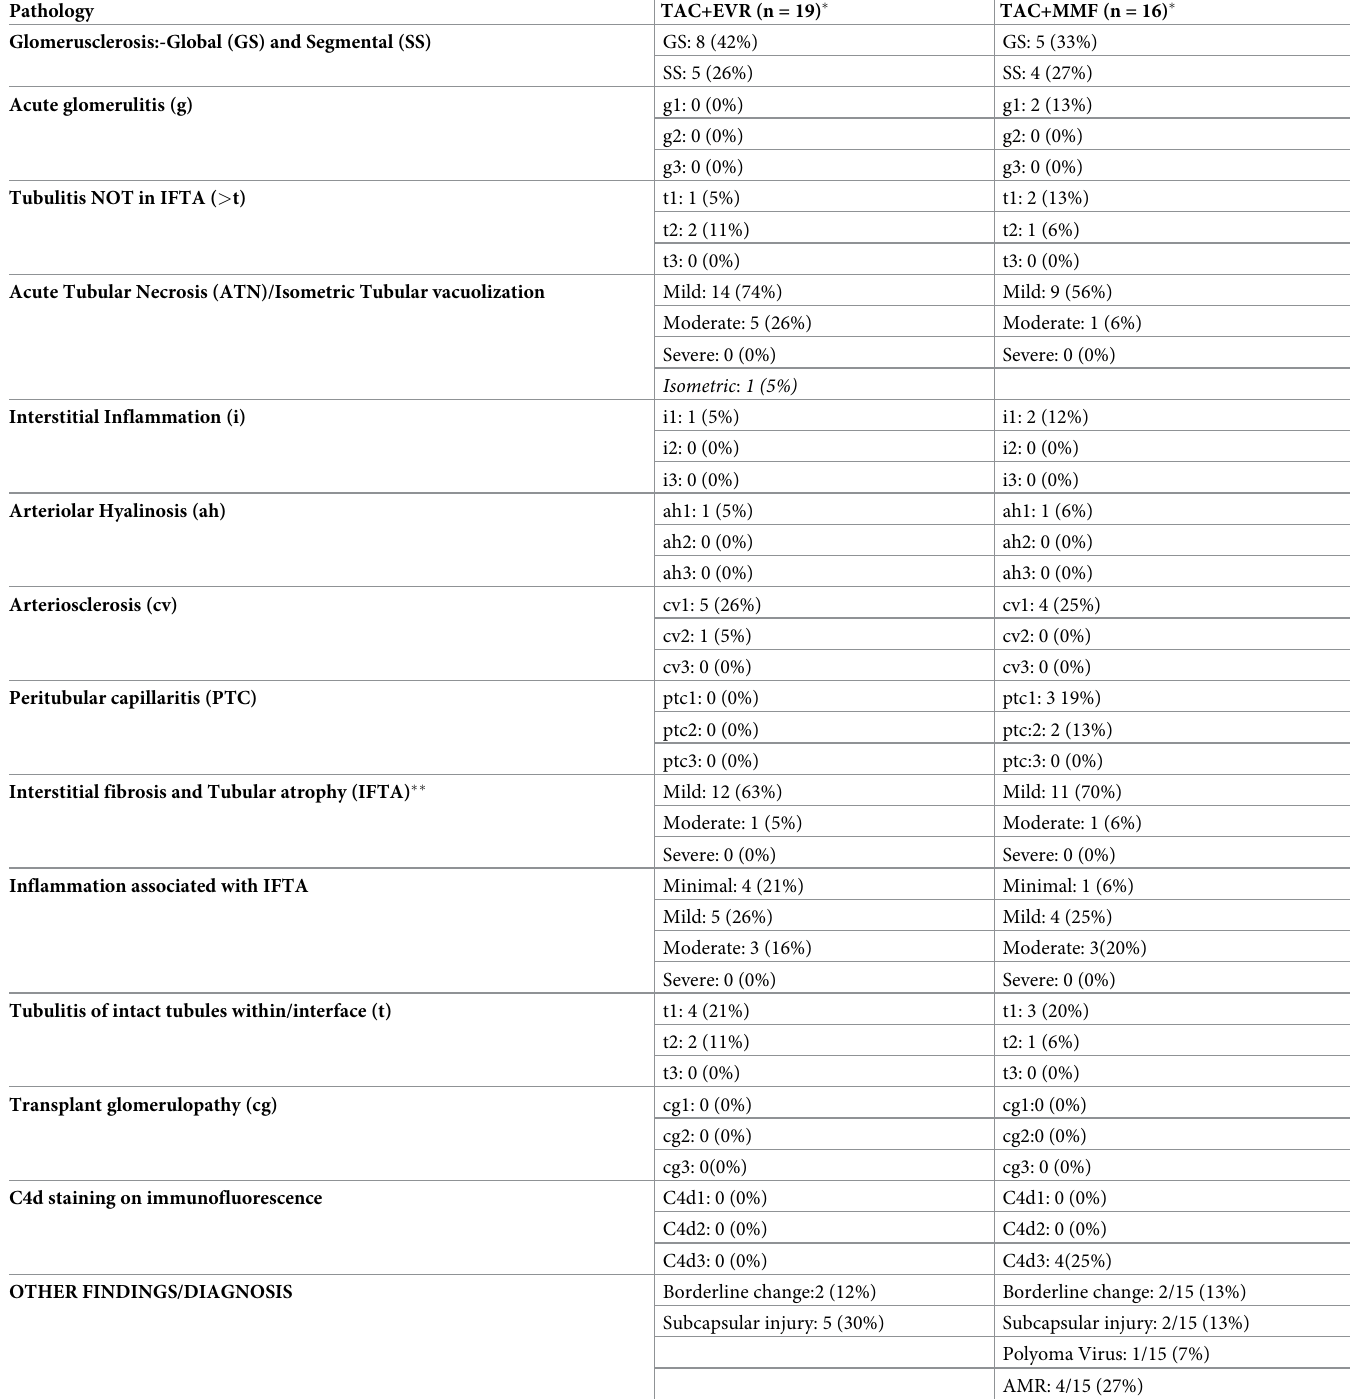
Table 3. Results– 12 month histopathology data.